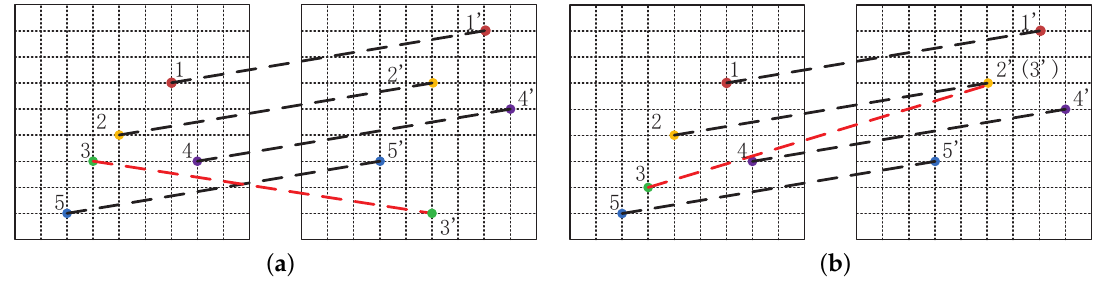
Figure 2. Illustration of mismatched features and many-to-one matched features.( a ) mismatched features; ( b ) many-to-one matched features.